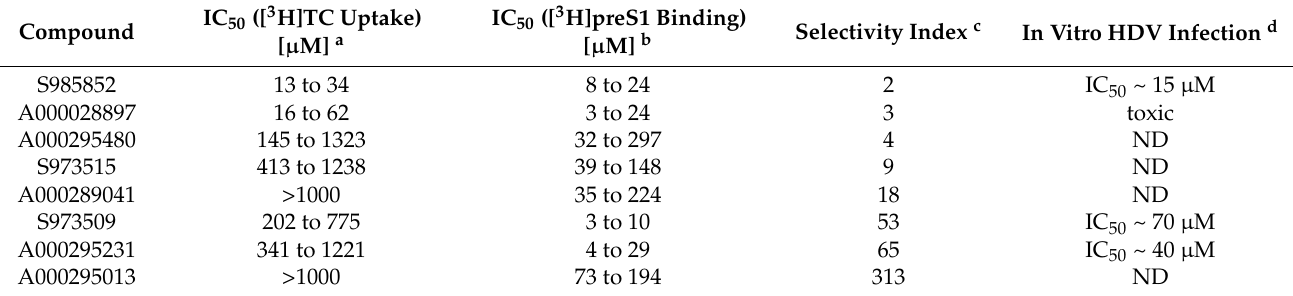
Table 1. The indicated compounds were analyzed for [ 3 H]TC transport inhibition and [ 3 H]preS1 binding inhibition in NTCP-HEK293 cells. IC 50 values were calculated from a range of five inhibitor concentrations (0.1–1000 µ M) and they are listed with their 95% confidence intervals. Selectivity indices for [ 3 H]TC transport inhibition/[ 3 H]preS1 binding inhibition were calculated from the IC 50 means. The higher this index, the more selective the respective inhibitor. Selected compounds were additionally tested for in vitro HDV infection in NTCP-HepG2